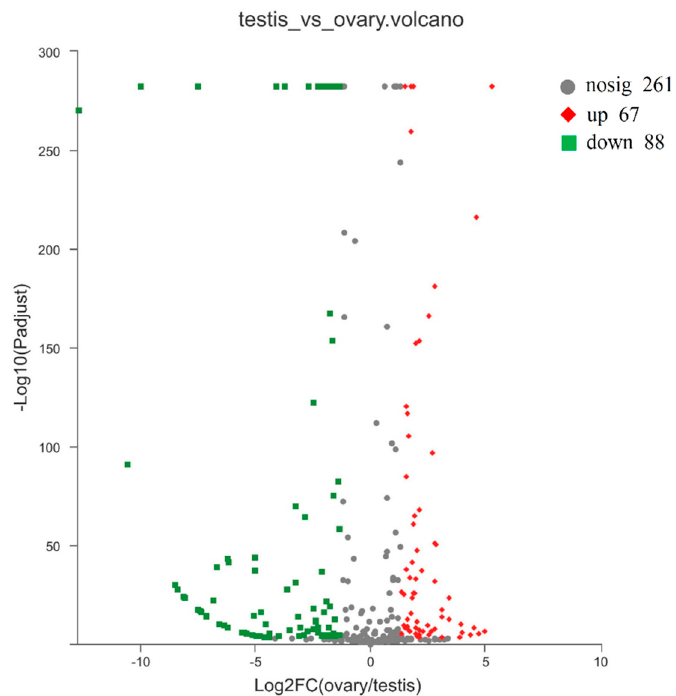
Figure 3. Volcano plot showing the miRNAs differentially expressed between the testis and the ovary. The ovary-biased miRNAs and testis-biased miRNAs are shown as red and green dots, respectively, whereas the miRNAs not differentially expressed are shown as gray dots.